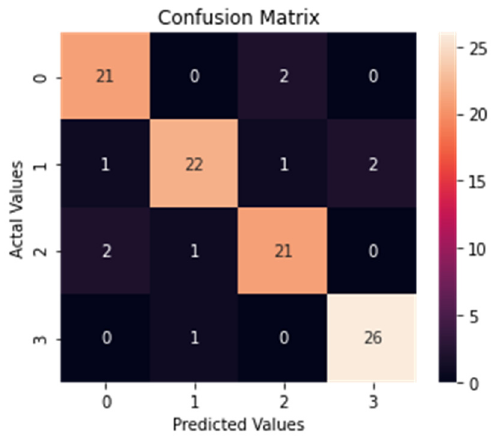
Figure 4. Confusion matrix of our model. Table 3. NTU RGB+D dataset showing an accuracy (%) comparison with previously proposed methods for cross-view (CV) and cross-subject (CS) evaluation.